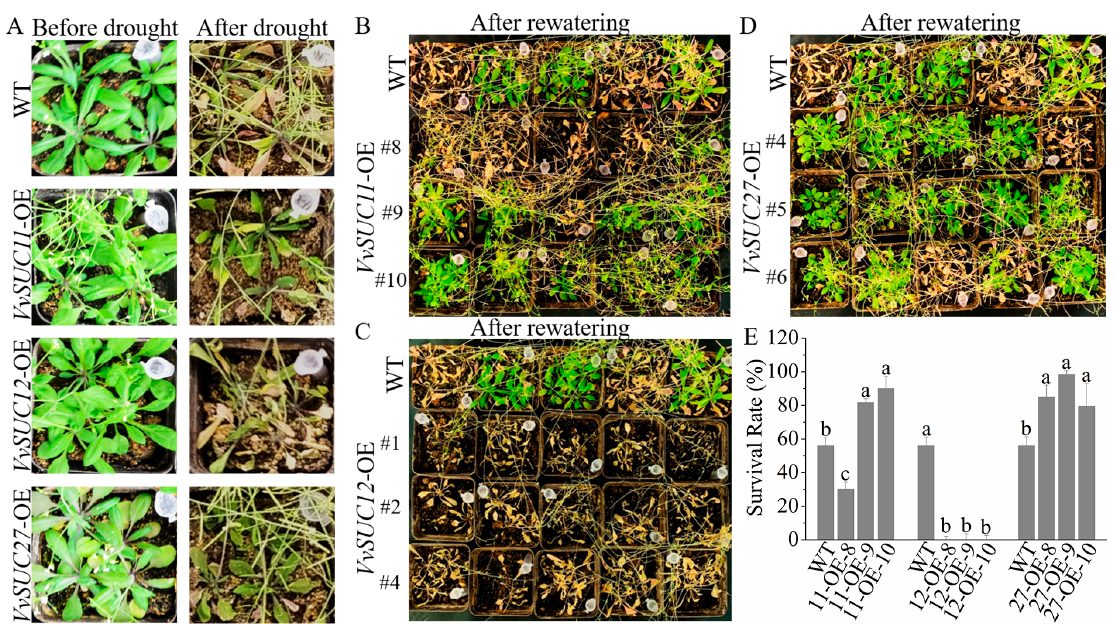
Figure 6. Phenotypic assays of VvSUC -OE Arabidopsis under drought stress. ( A ) Phenotypes of VvSUC -OE lines before drought and after drought for two weeks. ( B ) to ( D ) Phenotypes of ( B ) VvSUC11 -, ( C ) VvSUC12 -, and ( D ) VvSUC27 -OE lines, which had survived 2 weeks after rewatering. ( E ) Survival rate of VvSUC -OE lines after rewatering for two weeks. The survival rates were calculated based upon three biological replicates. Each biological repeat had 20-25 seedlings (four or five seedlings for each pot) for each genotype. Data are expressed as mean ± SD (n = 3). Di ff erent letters indicate significant di ff erences ( P < 0.05) between each VvSUC -OE line and WT, as determined by ANOVA followed by Tukey’s test.